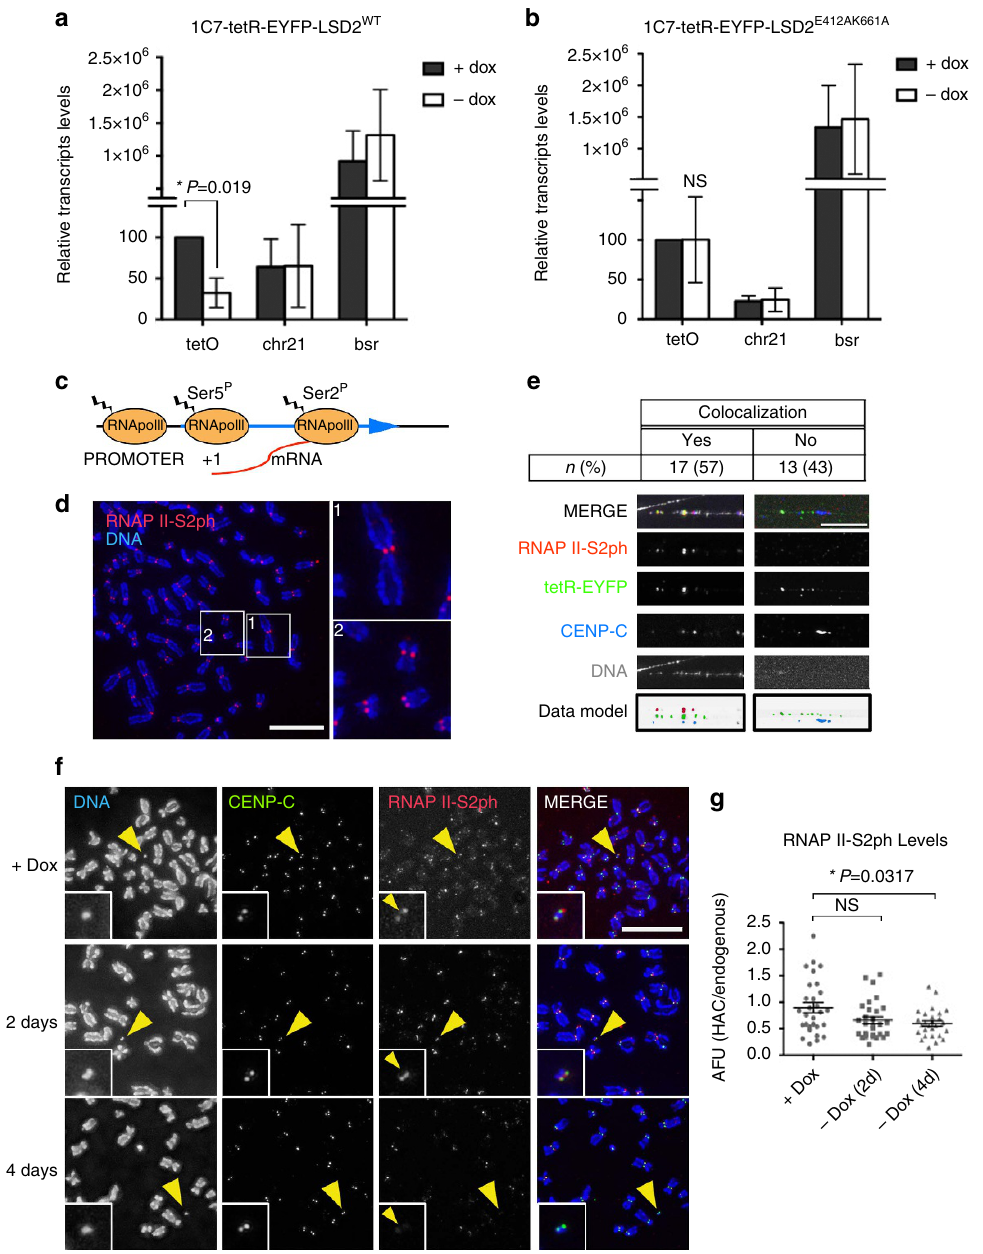
Figure 2 | Tethering LSD2 to the alphoid tetO HAC affects centromeric transcription. RT-PCR analysis of the centromeric transcripts in 1C7 cells expressing tetR-EYFP-LSD2 WT ( a ) or tetR-EYFP-LSD2 E412AK661A ( b ) in the presence of doxycycline (grey bars) and after 2 days of doxycycline washout (white bars). tetO (alphoid tetO array), chr21 (centromere of chromosome 21) and bsr (Blasticidine resistance gene). Data represent the mean and s.e.m. of three independent experiments. ( c ) Schematic diagram representing the states of RNAP II during transcription. ( d ) Immunofluorescence analysis of unfixed 1C7 metaphase chromosomes stained with RNAP II-S2ph. DNA was counterstained with DAPI. Scale bar, 10 m m ( e ) Analysis of RNAP II-S2ph with CENP-C on the HAC on stretched chromatin fibres. The HAC was detected with tetR-EYFP and DNA was counterstained with DAPI. Images show co-localization of RNAP II-S2ph and CENP-C on the HAC (left) and a fibre without RNAP II-S2ph signal (right). Bottom panels show a pseudocolored model using the inverted data from individual raw images. Scale bar, 5 m m. ( f ) Representative immunofluorescence images of 1C7 metaphase spreads expressing tetR-EYFP- LSD2 WT fusion protein in the presence of doxycycline (top) and after doxycycline washout at the indicated time points. Metaphase chromosomes were stained with DAPI, CENP-C and RNAP II-S2ph. Arrowheads depict the HAC. Scale bar, 10 m m. ( g ) Quantification of fluorescence signals of HAC kinetochore-associated RNAP II-S2ph staining in cells expressing tetR-EYFP-LSD2 WT in the presence of doxycycline and after doxycycline washout at the indicated time points. Values of the HAC kinetochore-associated RNAP II-S2ph signal were normalized for the mean of the RNAP II-S2ph signals at endogenous kinetochores. Solid bars indicate the medians and error bars represent the s.e.m. Results of two independent experiments were plotted together. Asterisks indicate a significant difference ( P o 0.05; Mann–Whitney’s